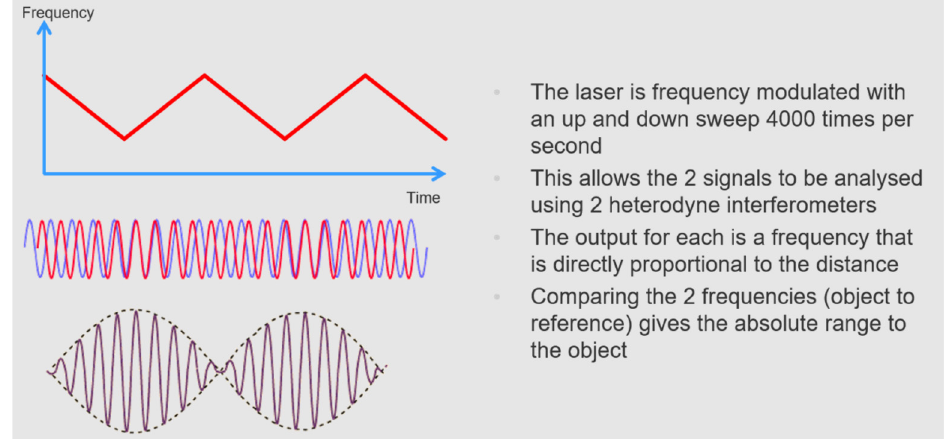
Figure 6. The principal functional operation of a laser radar. By the courtesy of LK Scandinavia.